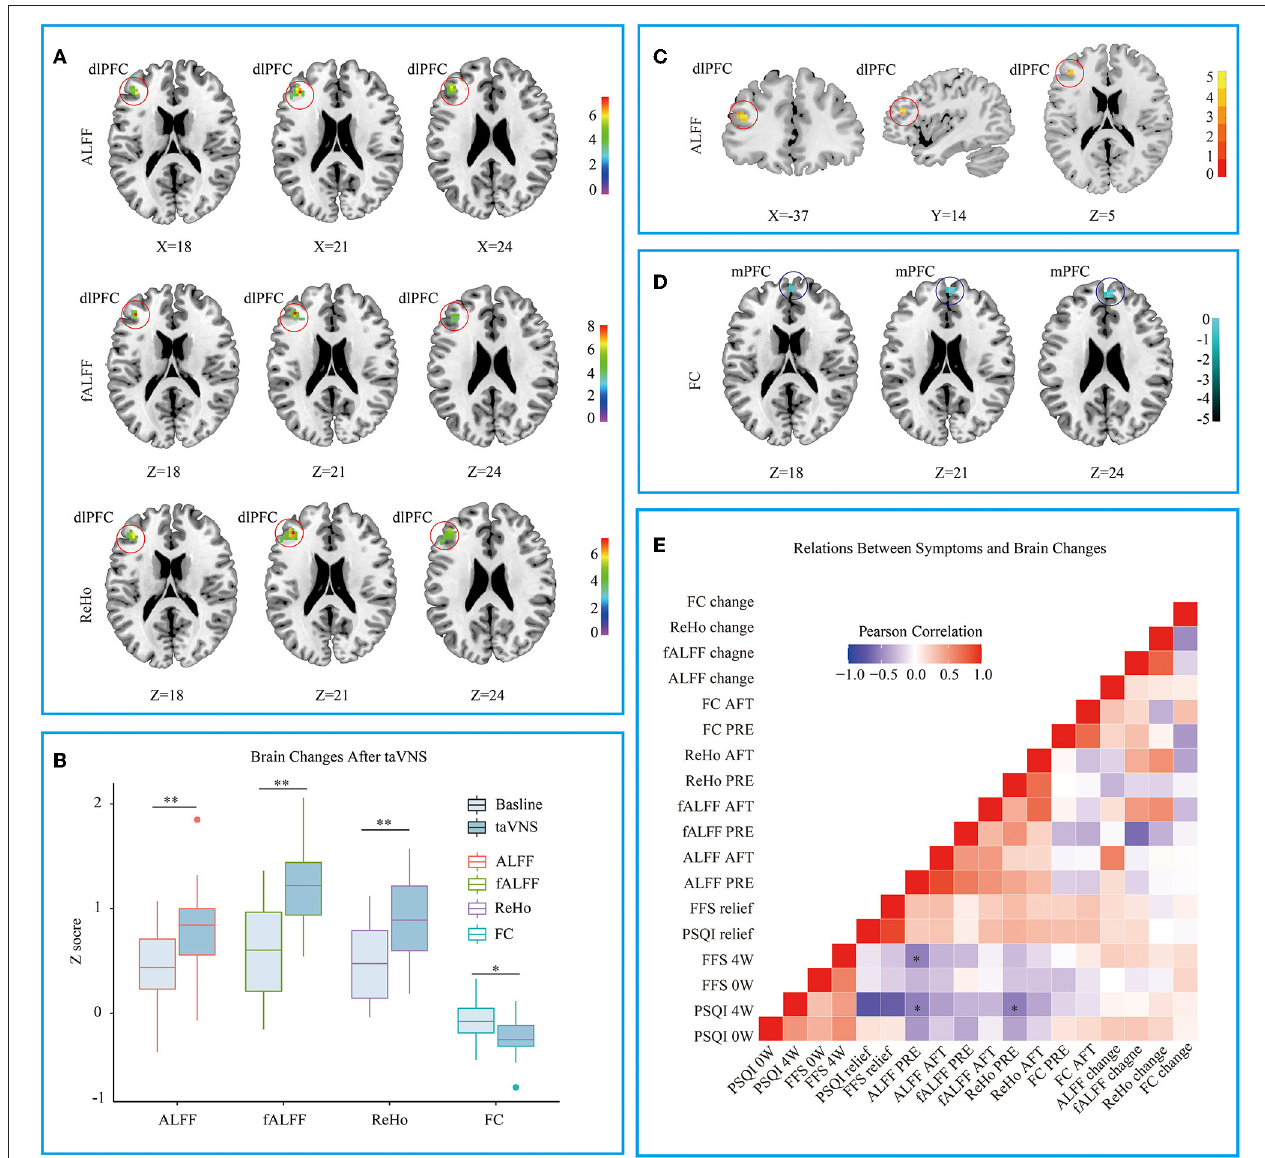
FIGURE 3 | (A) Different voxel based analyses showed similar up- regulated area in left dorsolateral prefrontal cortex. (B) Changes of different voxel based analyses before and after taVNS. (C) ALFF analysis showed taVNS aroused higher activation in the CI group than in the HC group. (D) The FC between the up- regulated dlPFC and bilateral dorsomedial prefrontal cortex decreased after taVNS. (E) Correlations between the clinical scales’ scores and the fMRI values. PSQI, Pittsburgh Sleep Quality Index; FFS, Flinders Fatigue Scale; ALFF, amplitude of low frequency fluctuation; fALFF, Fractional ALFF; ReHo, Regional homogeneity; FC, Functional connectivity; 0w, before taVNS treatment; 4w, after 4 week taVNS treatment; Relief Rate, The remission rate was defined as the difference in scale scores before and after treatment divided by the scale scores before treatment. * p < 0.05; ** p <